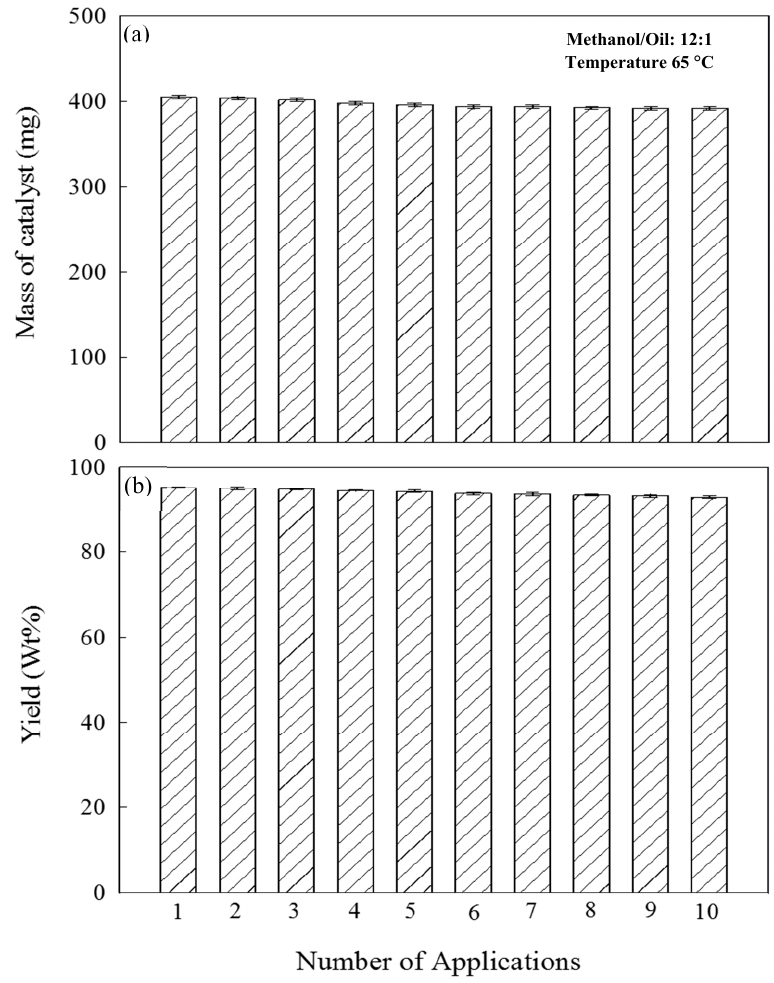
Figure 7. The mass of recycled catalyst ( a ) at the end of ten consecutive experiments and ( b ) the effects of catalyst stability on the yield of FAME.